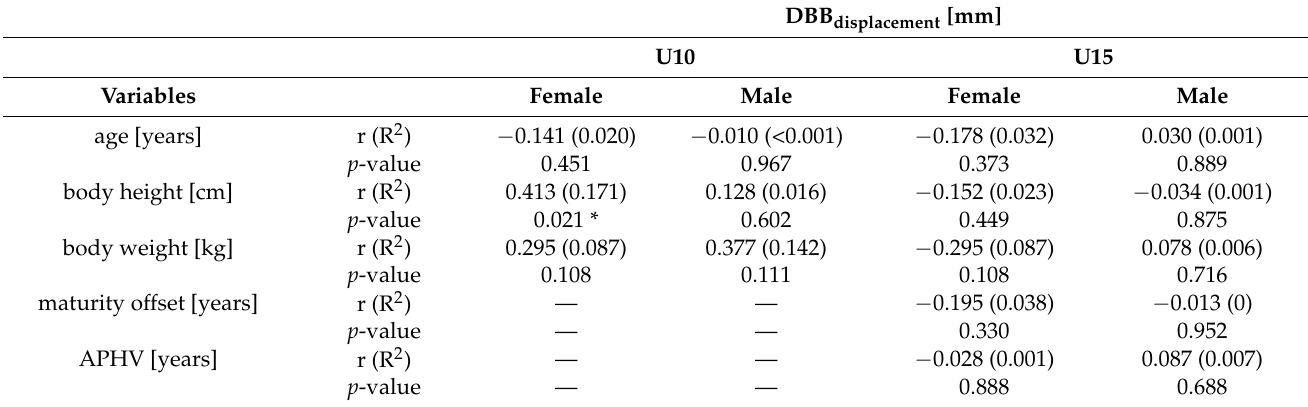
Table 3. Pearson’s correlations coefficient (r), determination coefficient (R 2 ) and p -values for the correlation between DBB displacement and age, body height, body weight, APHV and maturity